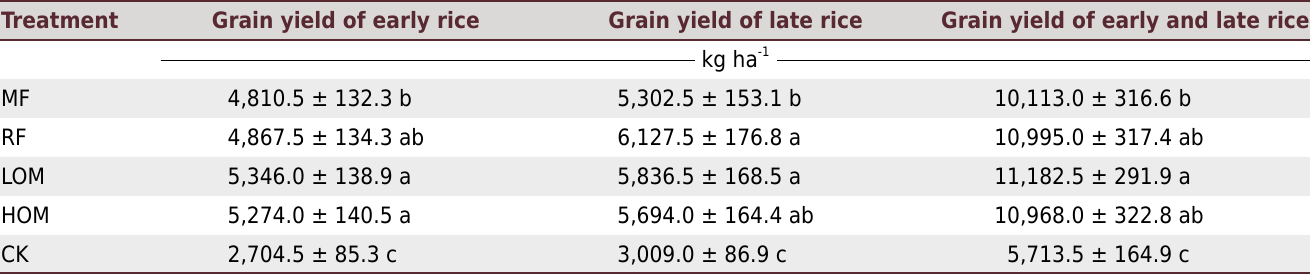
organic matter and 40 % mineral fertilizer; CK = without fertilizer input. Different letters indicate significance at p < 0.05 among the fertilization treatments, according to the least significant difference